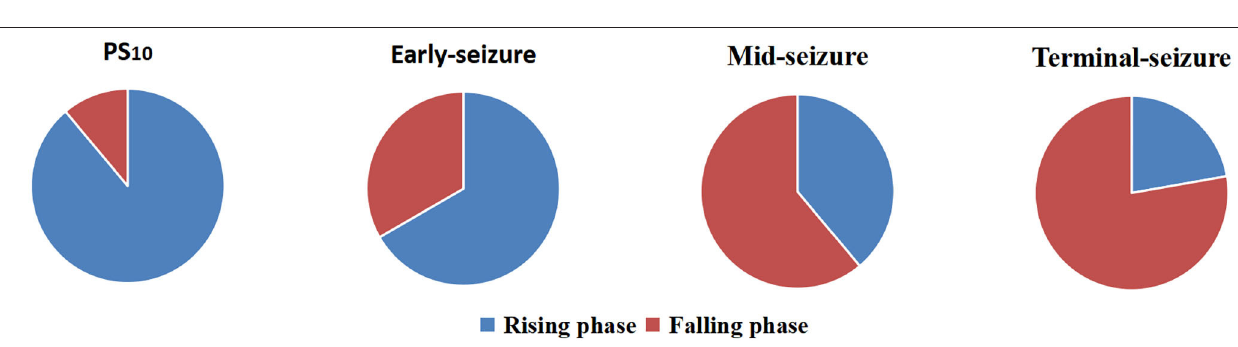
FIGURE 3 | Statistics of preferred phases at four different periods of 18 episodes. The result showed that the preferred phases of coupling were usually in the rising branch at the PS 10 and early-seizure, while that of the mid- and terminal-seizure were usually in the falling